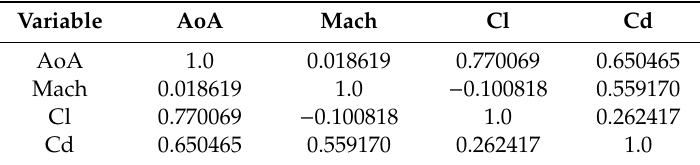
Table 7. Pearson correlation coe ffi cients in RAE2822 databases.